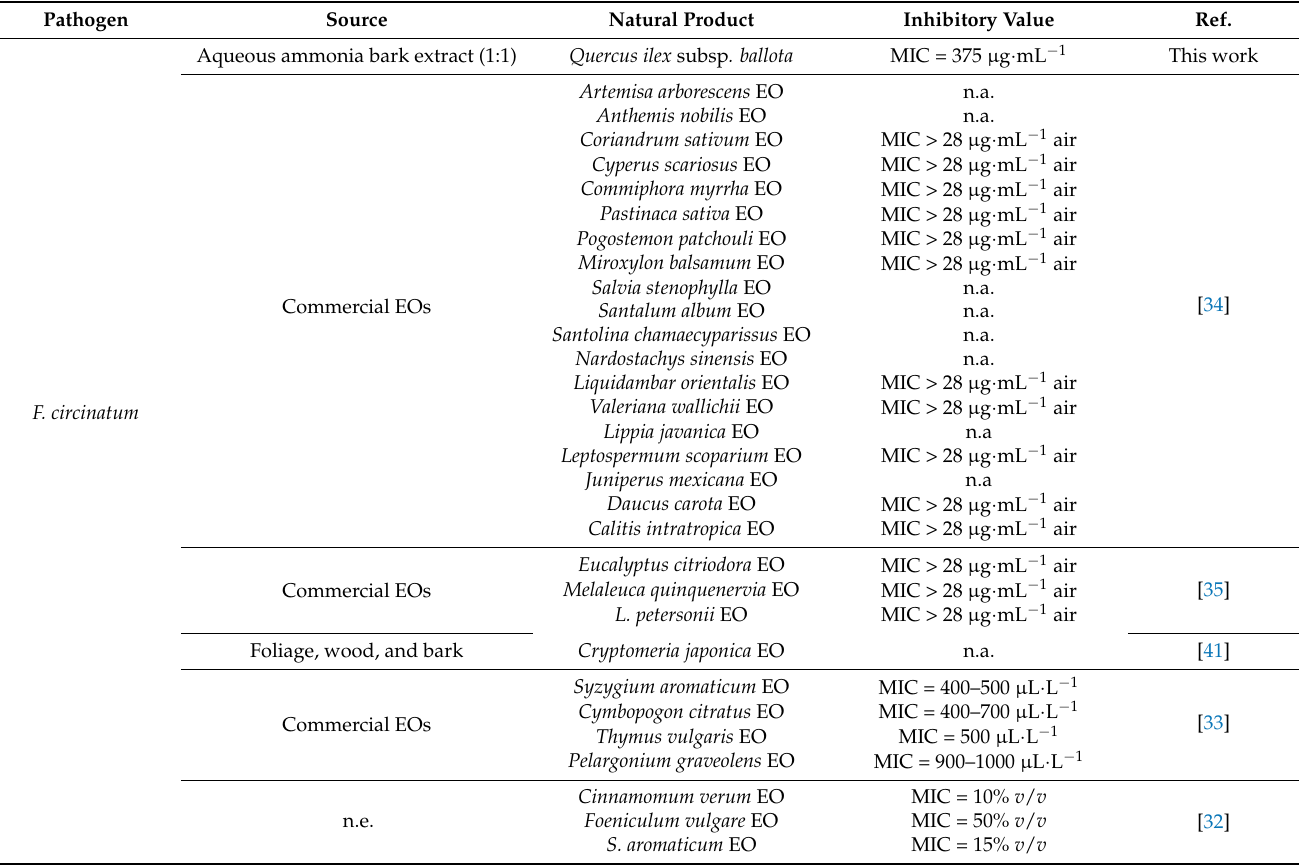
Table 3. Inhibition values reported in the literature for other bioactive natural products against the three pathogens under